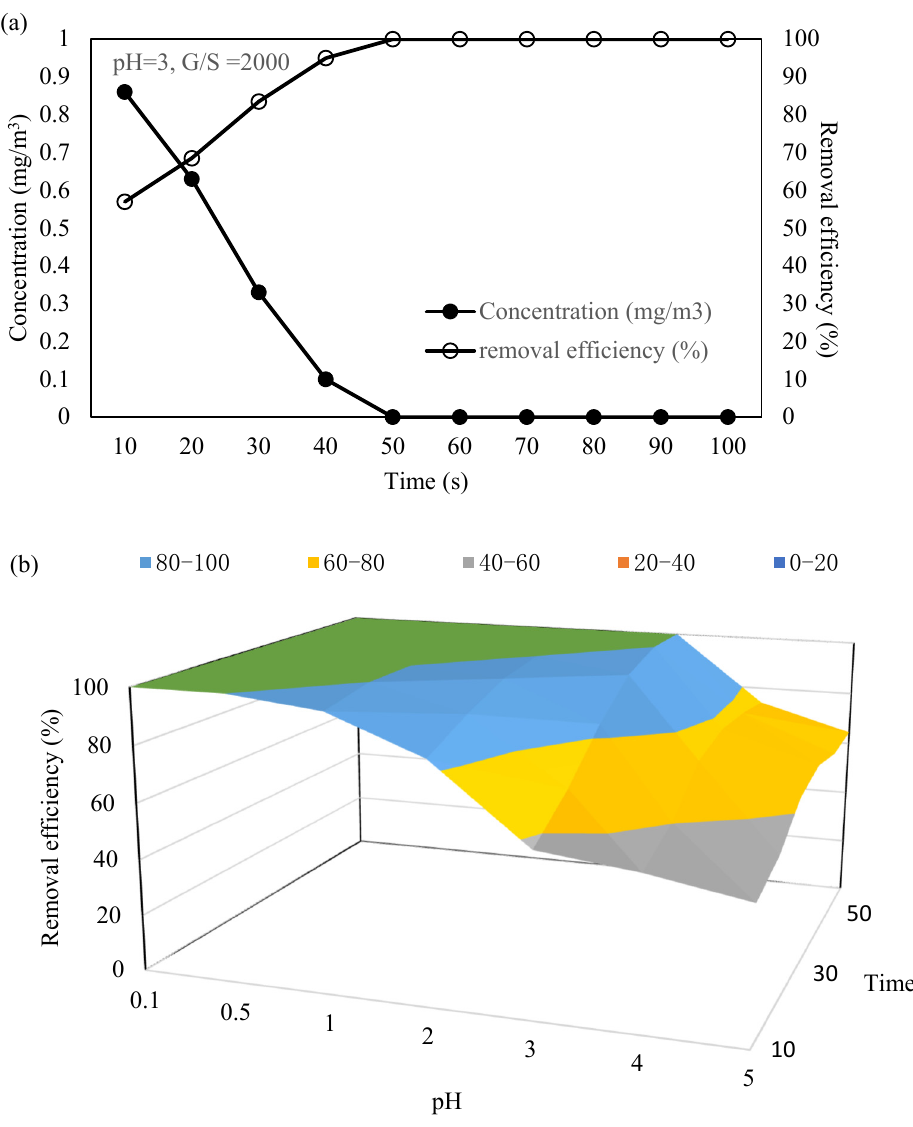
Figure 1. The ammonia removal by chemical scrubbing (( a ): ammonia removal at pH 3; ( b ): the ammonia removal at different pH and retention